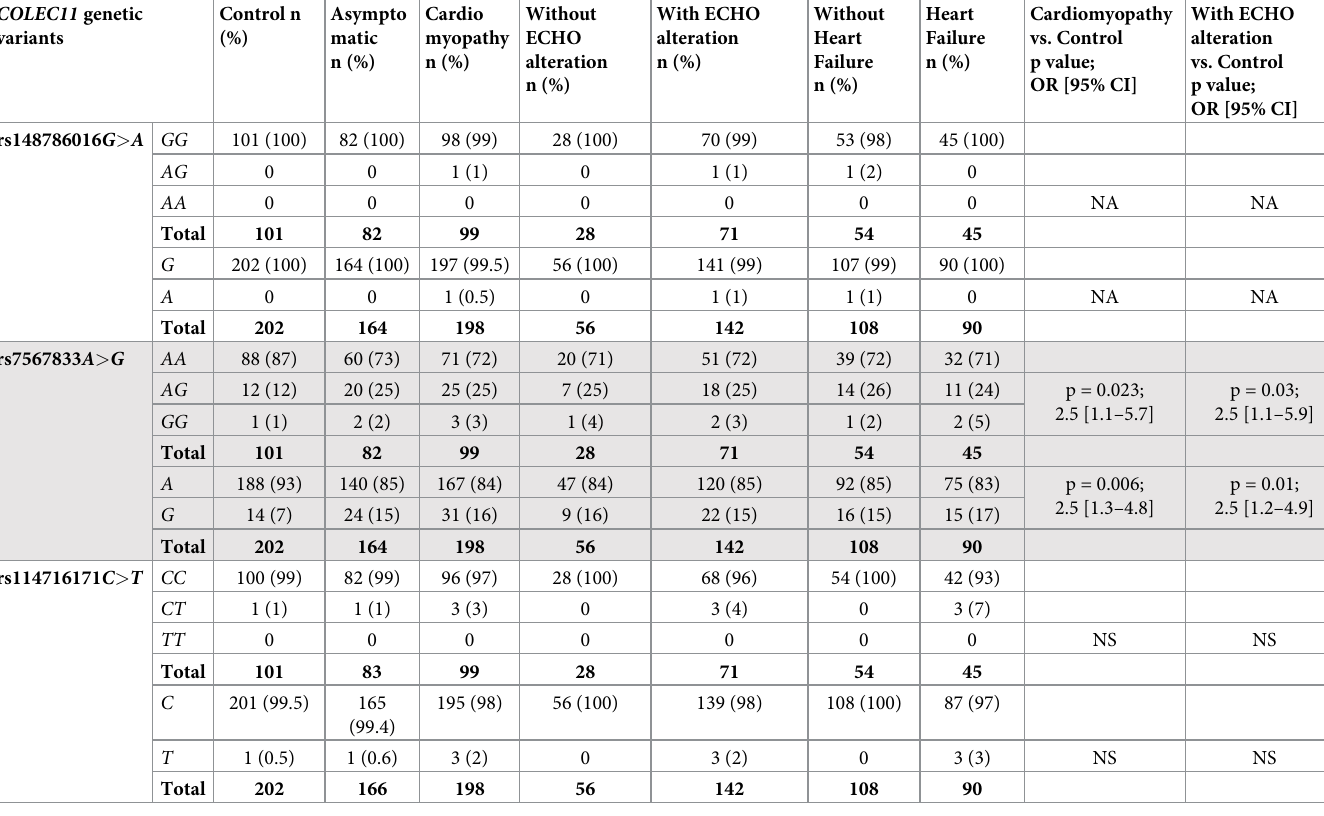
Table 3. COLEC11 genotypes and alleles frequencies in patients with chronic CD based on cardiomyopathy. COLEC11 genetic